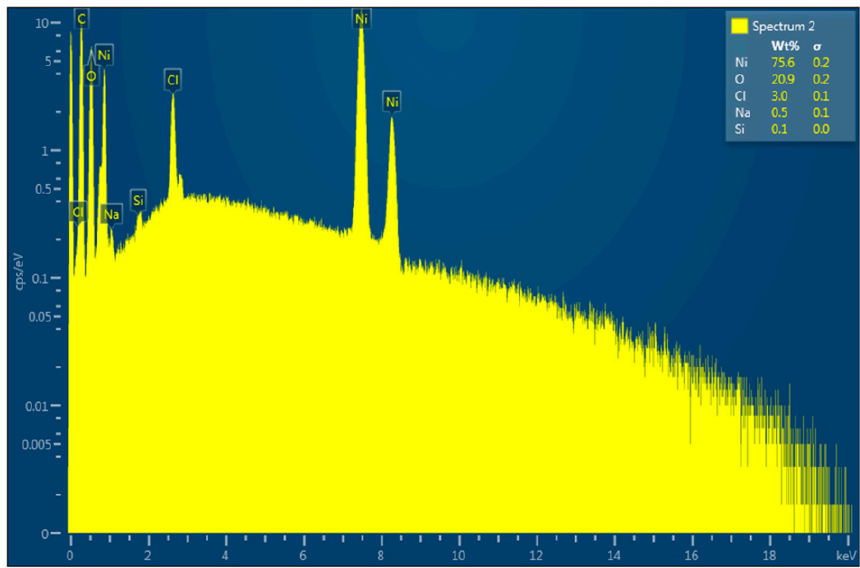
Figure 7. EDX spectrum of the NiO